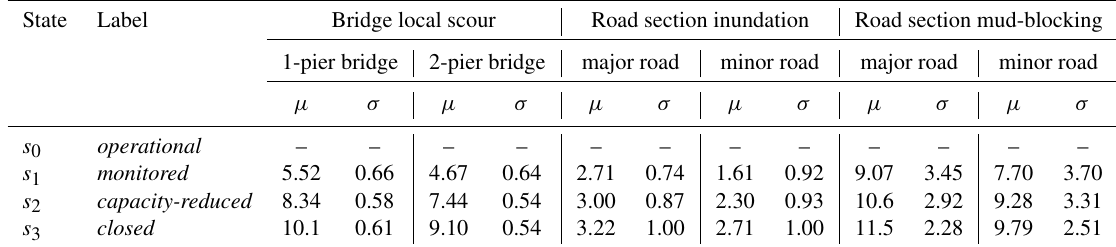
Table 2. Fragility function parameters for bridge local scour, road section inundation and road section mud-blocking.